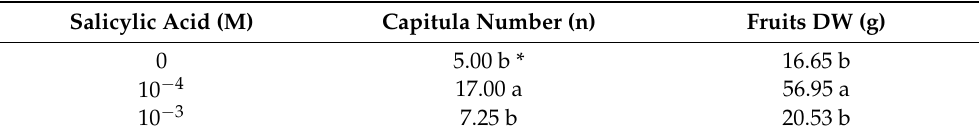
Table 3. Effect of different concentrations of salicylic acid on capitula number (n) and fruit DW (g) of S. marianum L.